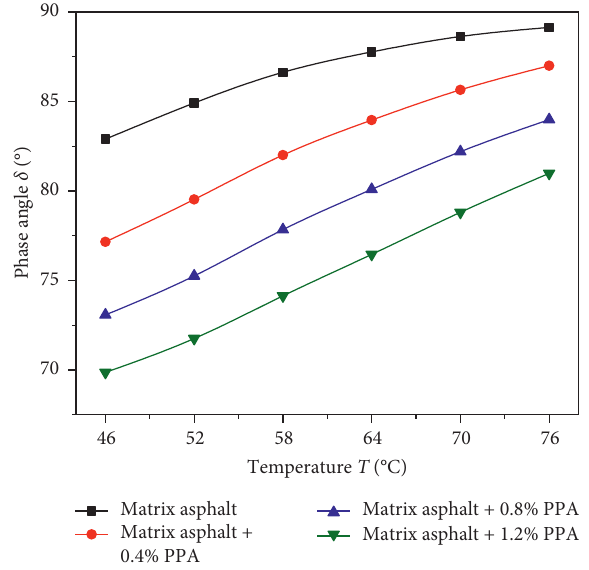
Figure 4: Effect of PPA content on the phase angle of PPA- modified